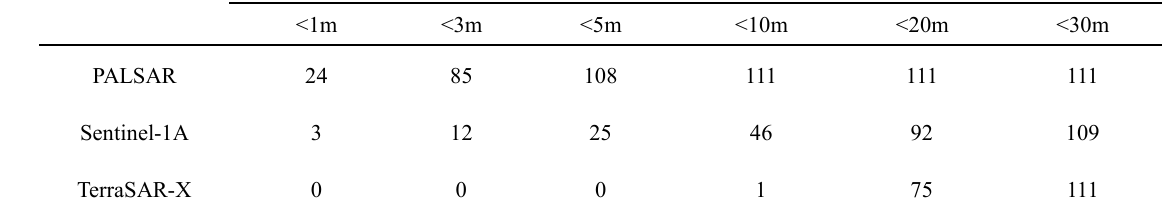
Table 3 the difference of DEM between InSAR technique and 1:10000 topographic map